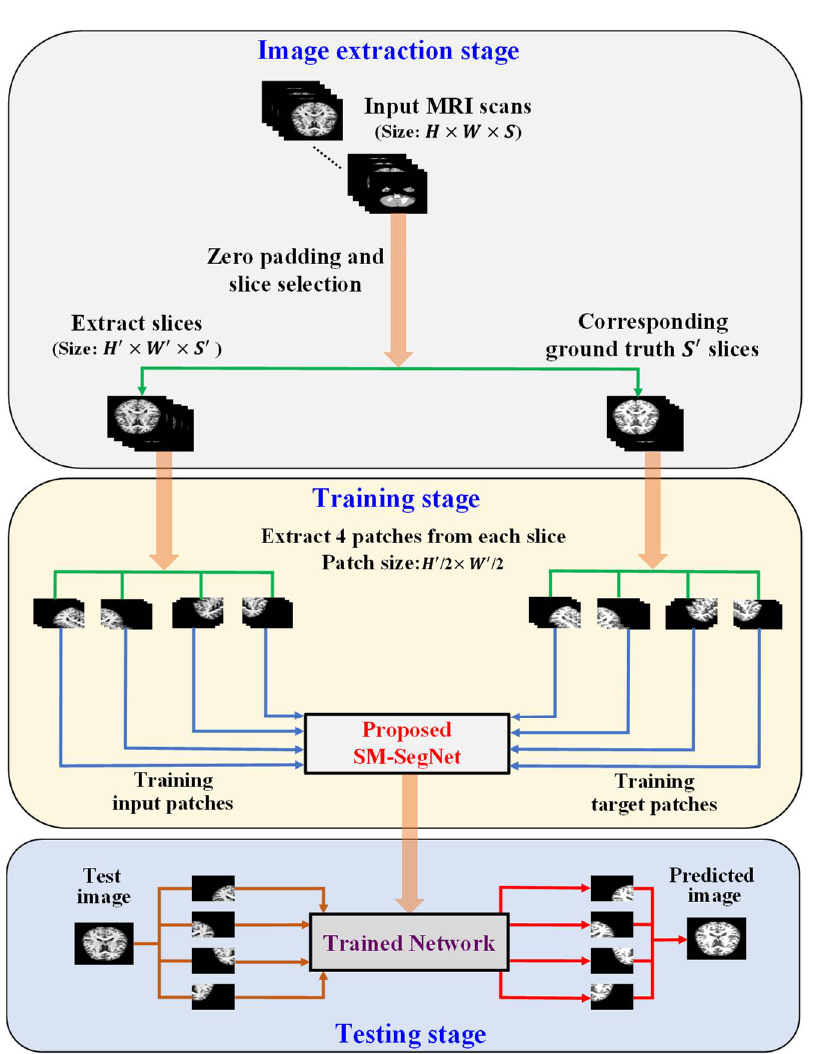
Figure 2. The pipeline for the overall process of the proposed method.